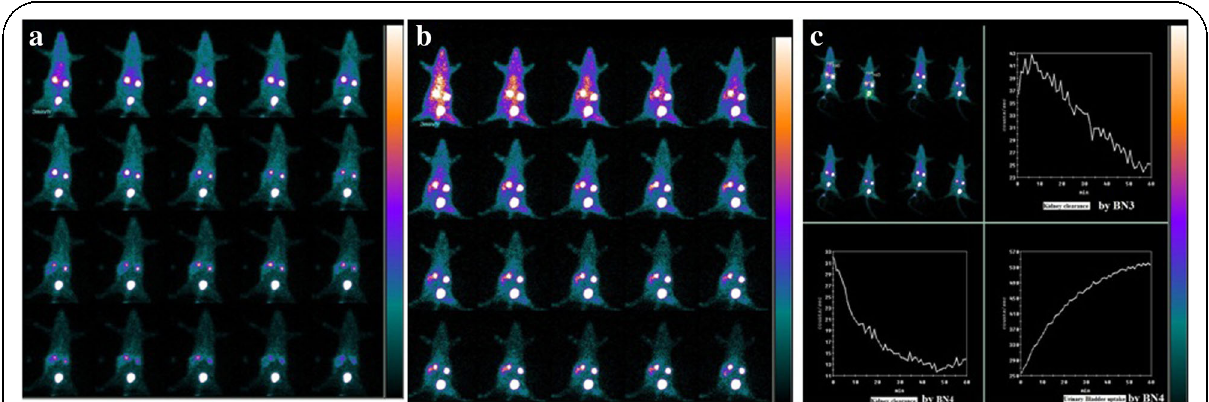
Fig. 11 Scintigraphic images of MDA-MB-231 cell induced tumor bearing mice at different time period after intravenous injection of 99m Tc-BNS ( a ) and 99m Tc-BN4 ( b ). Gamma camera images with renogram curves ( c ) after intravenous administration of 99m Tc-BN3 and 99m Tc-BN4 in mice for